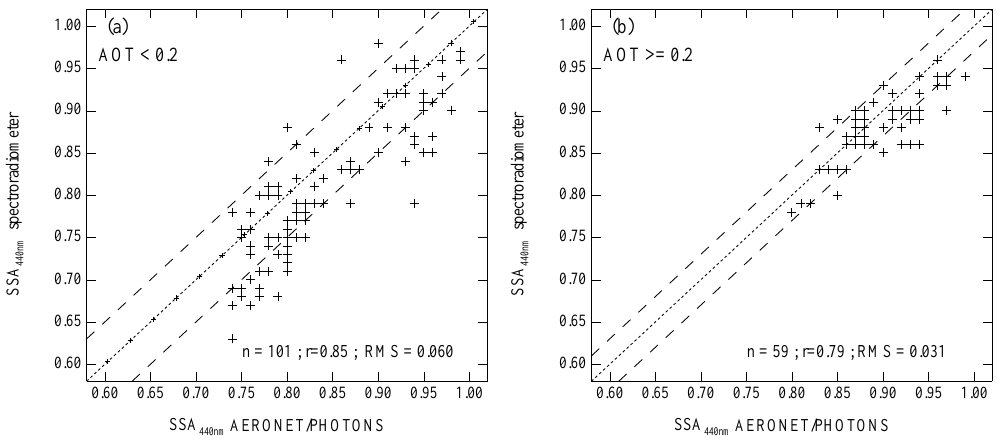
Fig. 4. Scatter plots of SSA retrieved at 440nm from the spectroradiometer versus SSA from AERONET/PHOTONS for the period 2003– 2006: (a) for AOT lower than 0.2; (b) for AOT greater than or equal to 0.2. The micro-dash line is the first bisector and dash lines are located at ± 0.05 for AOT < 0.2 and ± 0.03 for AOT ≥ 0.2, values corresponding to AERONET uncertainties. The correlation coefficient is indicated, n is the number of points and RMS is the Root Mean Square of the difference